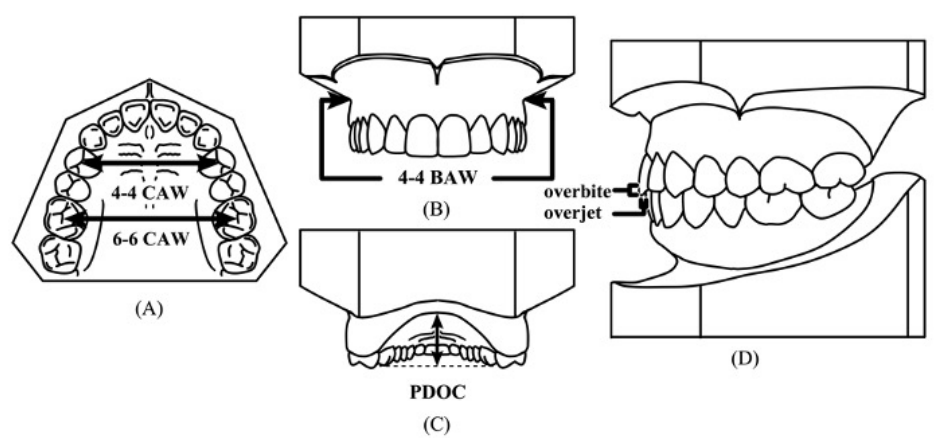
Figure 6. Odontometric variables used in the dental casts analysis. ( A ) Crown arch width (4-4 CAW): measured width of the dental arch between the buccal cusps of the first permanent premolars. Crown arch width (6-6 CAW): measured width of the dental arch between the mesio-buccal cusps of the first permanent molars. ( B ) Basal arch width (4-4 BAW): measured width of the basal arch between the most concave points of the basal bone at the first permanent premolar area. ( C ) Palatal depth from occlusal plane (PDOC): the deepest point of the palate intersecting at a point perpendicular to the mid-palatal raphe and a line connecting the mesio-buccal cusps of the first permanent molars bilaterally. ( D ) Overjet and overbite, as defined in the previous section.